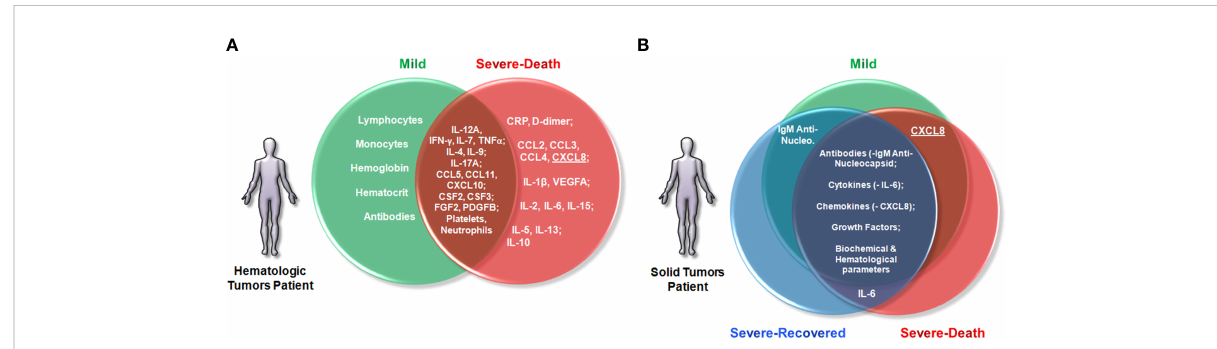
FIGURE 9 Patients with hematologic malignancies and solid tumors display distinct circulating immune pro fi les associated with clinical outcomes. Venn diagrams were drawn to summarize the fi ndings of this study, highlighting factors with higher concentrations between the groups. Early increased immune cells and antibody production were associated with mild COVID-19, whereas increased concentrations of in fl ammatory immune markers were associated with death in the Onco-hematologic group (A) . On the other hand, only IL-6 was associated with death among patients with solid tumors. In fact, for those patients, death outcome was associated with a breakdown of coordinate production of antibodies and regulation of soluble factors rather than with broad differences in the concentrations of soluble mediators (B) . Lastly, although patients with hematologic and solid tumors display distinct pro fi les of soluble immune markers, CXCL8 (underlined) was an important early predictive factor of patients that would progress to death from COVID-19 across all cancers. Lymphocytes and monocytes refer to cell counts per mm 3 of blood. Antibodies refers to IgA, IgG and IgM anti-SARS-CoV-2 Nucleocapsid, Receptor Binding Domain, Spike 1 and Spike proteins. CRP, C-Reactive Protein; IL-1RN, Interleukin 1 Receptor